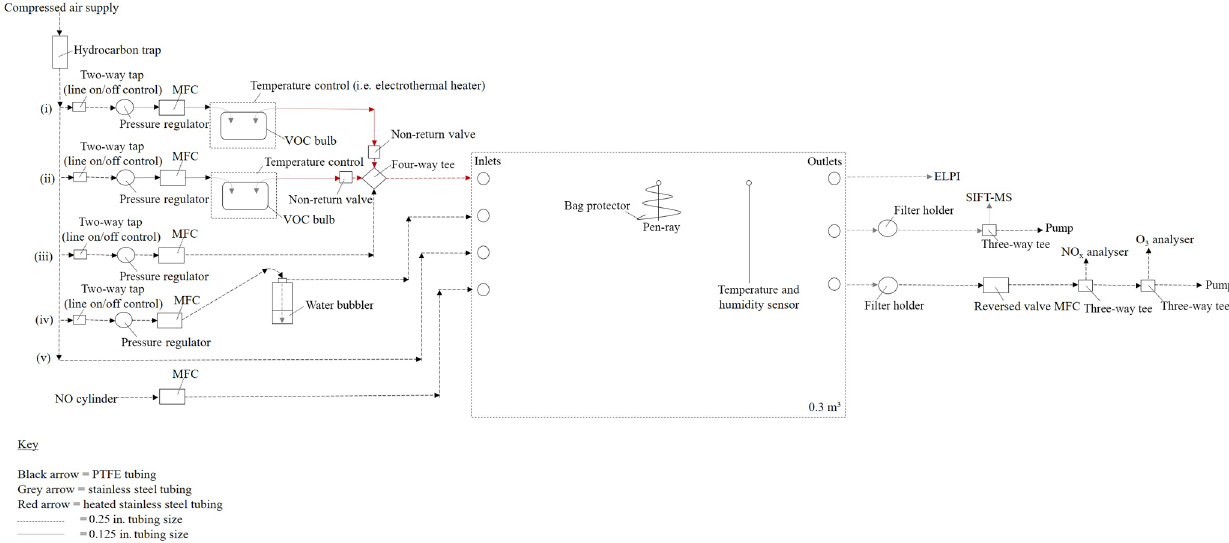
Figure 1. Detailed schematic of the continuous-flow reactor (CFR). Points (i) to (iv) refer to the text discussion of each introduction line; see Sect. 2.1.2. MFC is a mass flow controller, ELPI is a electrical low-pressure impactor and SIFT-MS is a selected ion flow tube mass